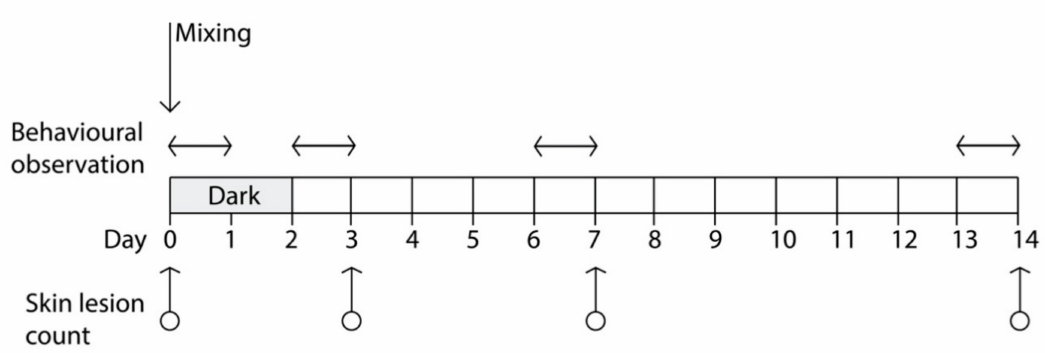
Figure 1. Schedule of skin lesion counting (on eight pens, n = 100 pigs) and behavior observations (on four pens, n = 48 pigs), relative to the day of mixing (Day 0); darkness was applied to half of the pens for the first 48 h after mixing (grey